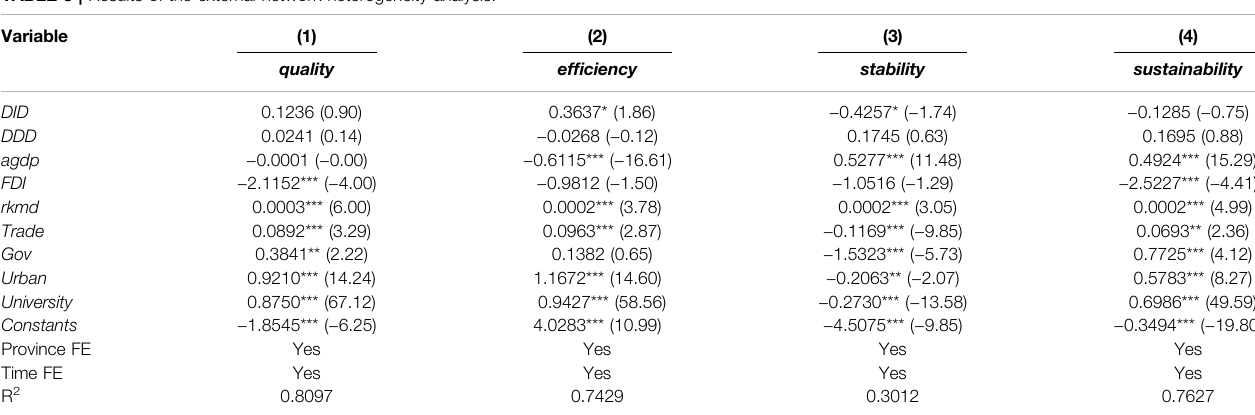
TABLE 8 | Results of the external network heterogeneity analysis.